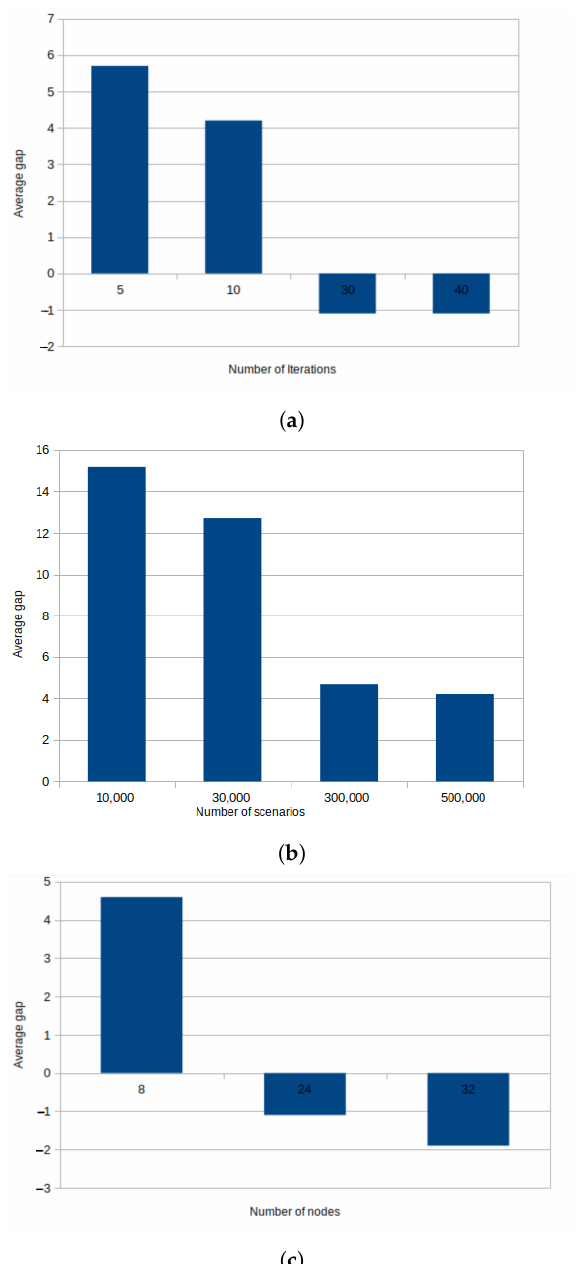
Figure 4. Sensitivity to key parameters: ( a ) Effect of number of policy iterations; ( b ) Effect of number of training scenarios; ( c ) Effect of number of NN hidden layer